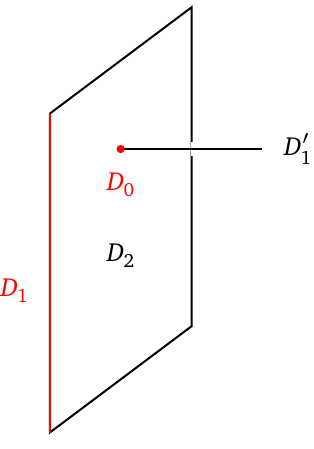
Figure 1: Example of non-genuine defects arising at junctions of genuine defects. Here D 1 and D are genuine line and surface defects respectively. D 2 1 line defect arising at the end of D and D is a non-genuine local operator that can 2 0 arise at an end of D 1 along D 2 1